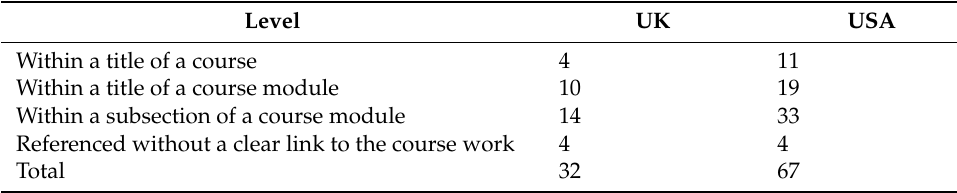
Table 1. Level of regulatory presence within a degree